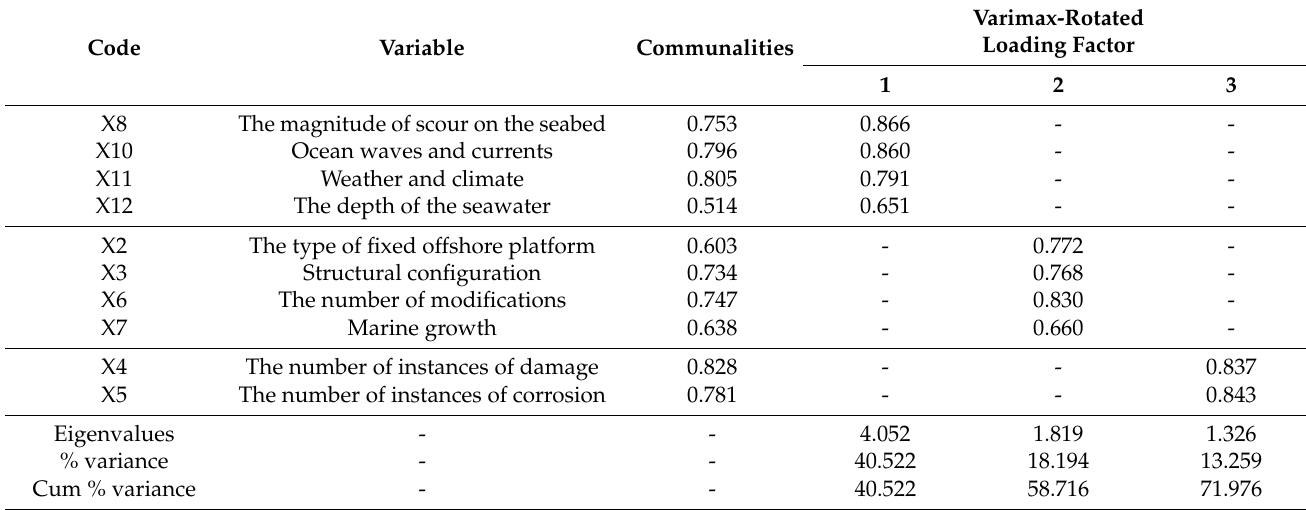
Table 6. Factor analysis